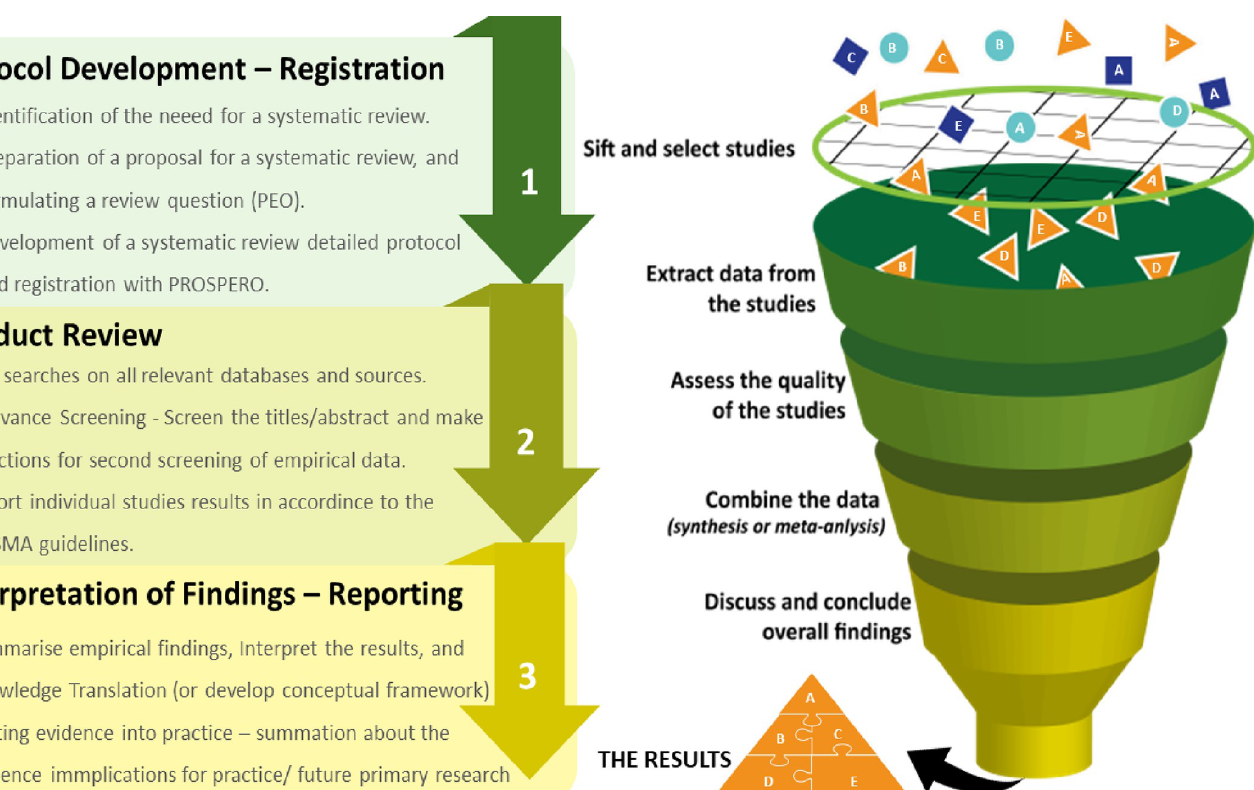
Fig 1. Schematic diagram of the seven steps of the methodological framework according to PRISMA. Source: Mulrow CD; 1994.